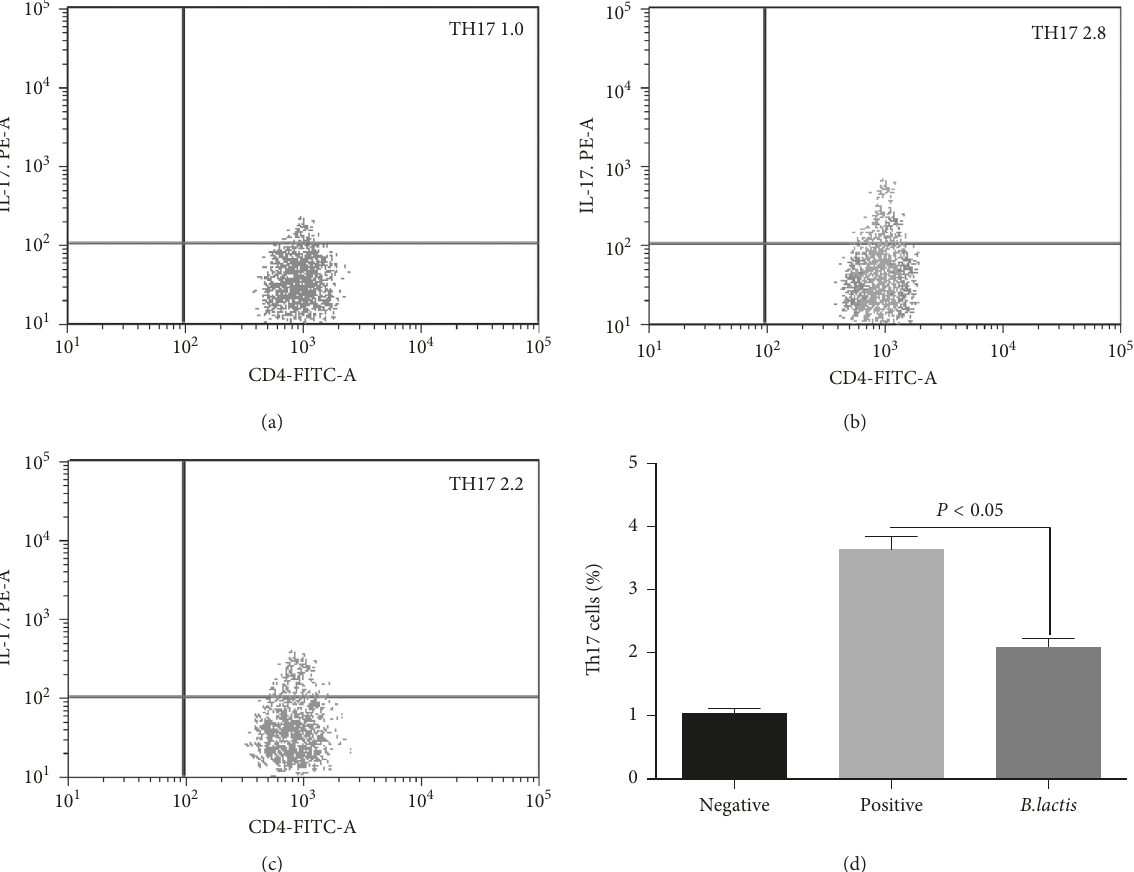
Figure 7: The effects of B. lactis on the percentage of Th17 cells in mouse allergy models. (a) The percentage of Th17 cells in the NG. (b) The percentage of Th17 cells in the PG. (c) The percentage of Th17 ells in the EG. (d) The effects of B. lactis on the percentage of Th17 cells. BALB/c mice were randomly divided into 3 groups ( n 8 in each group): negative control group (NG), positive control group (PG), and (cid:31) experiment group (EG). The mice from PG and EG were individually immunized with tropomyosin and cholera toxin. The mice from NG received cholera toxin in PBS. Subsequently, the mice from EG received B. lactis . n 8 for each group. CD4 + T cells were gated by CD4 (cid:31) expression and forward scatter characteristics. The statistical difference was significant if P 0 . <